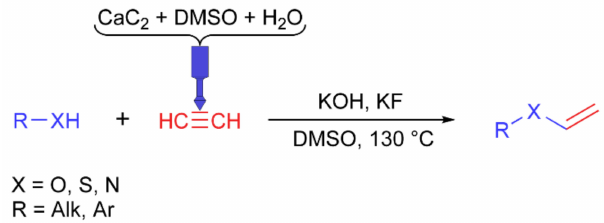
Figure 6. Vinylation